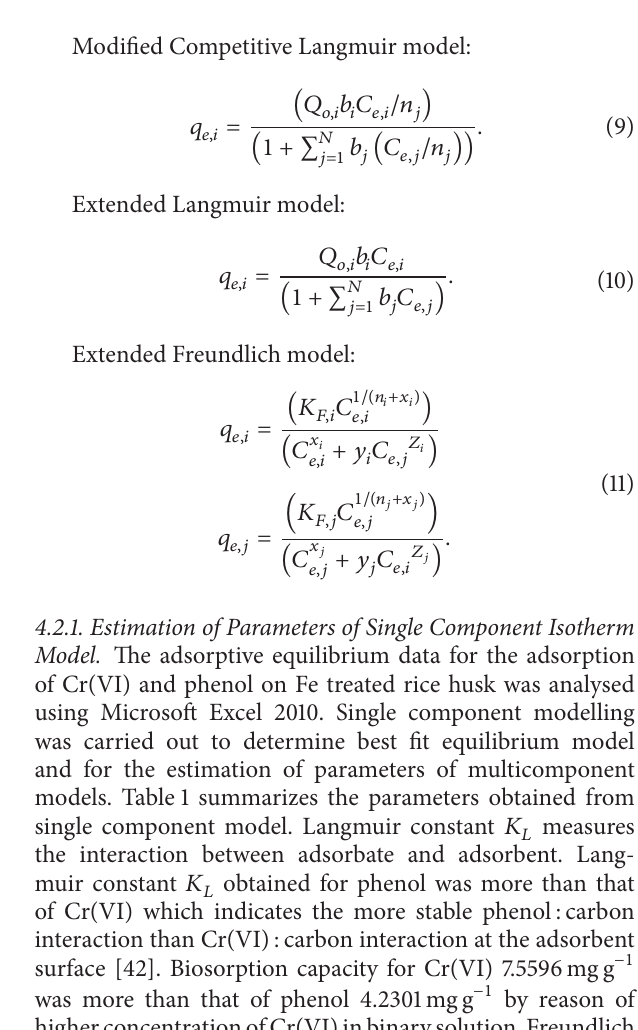
Figure6:EffectofcontacttimeonadsorptionofCr(VI)andphenol.